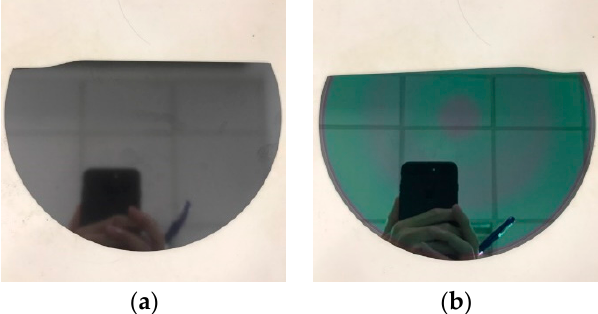
Figure 2. ( a ) The matrix layer of the GaN waste ( b ) The coating layer of the GaN waste.